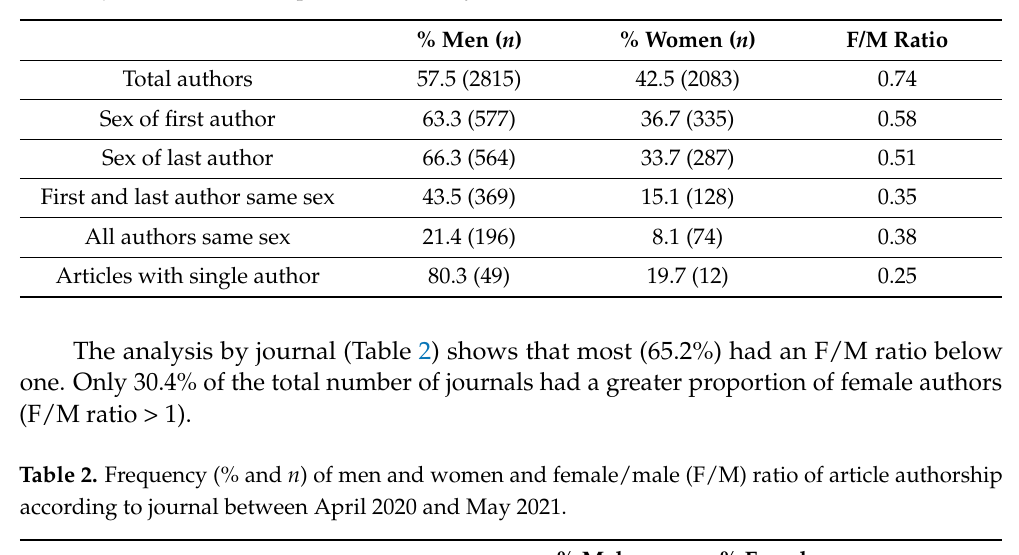
Table 1. Indicators of author order and composition according to sex (% and female/male (F/M) ratio) of journals between April 2020 and May 2021.